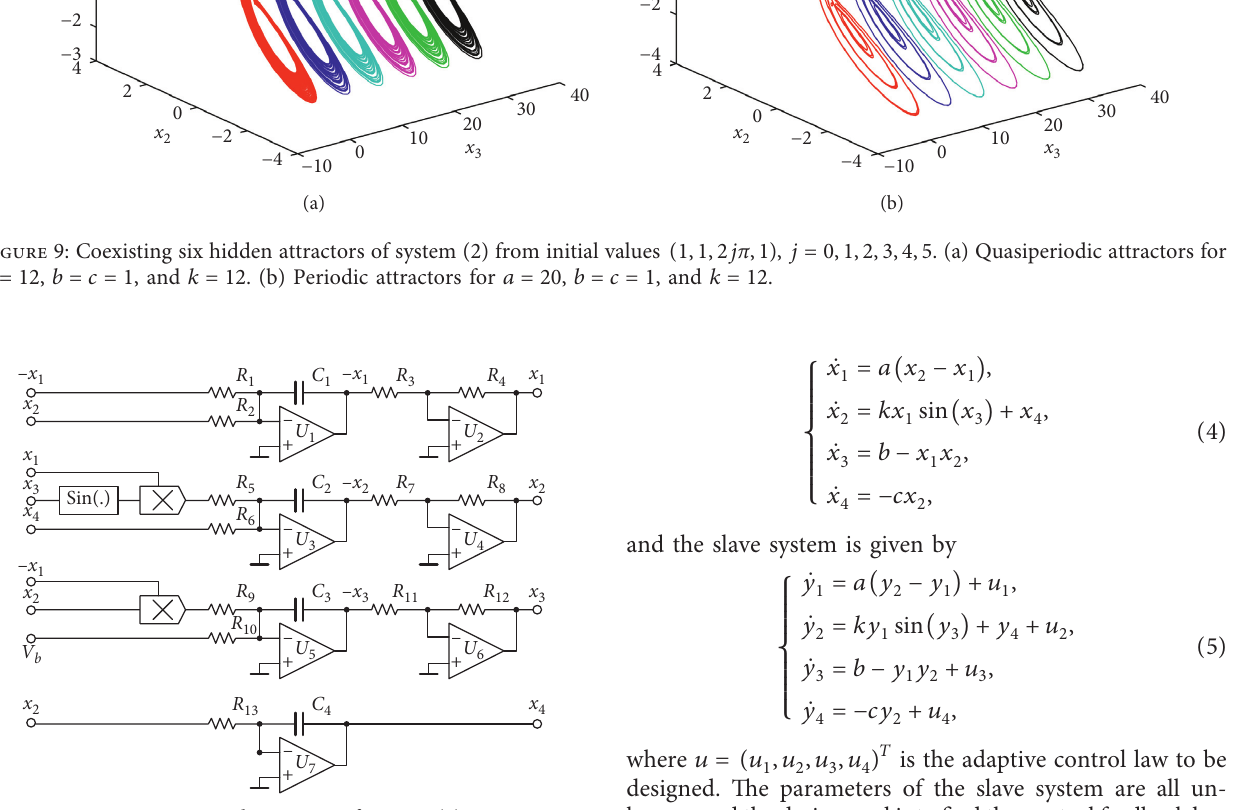
Figure 10: Analog circuit of system